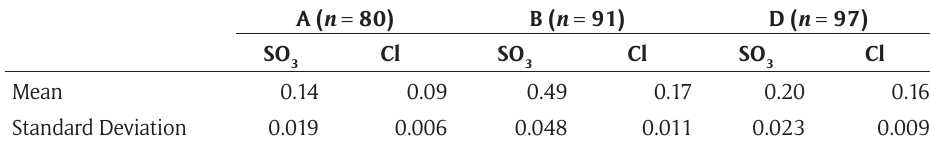
Table 1: Mean and standard deviation of n analyses for SO expressed as oxide weight percent (wt%).